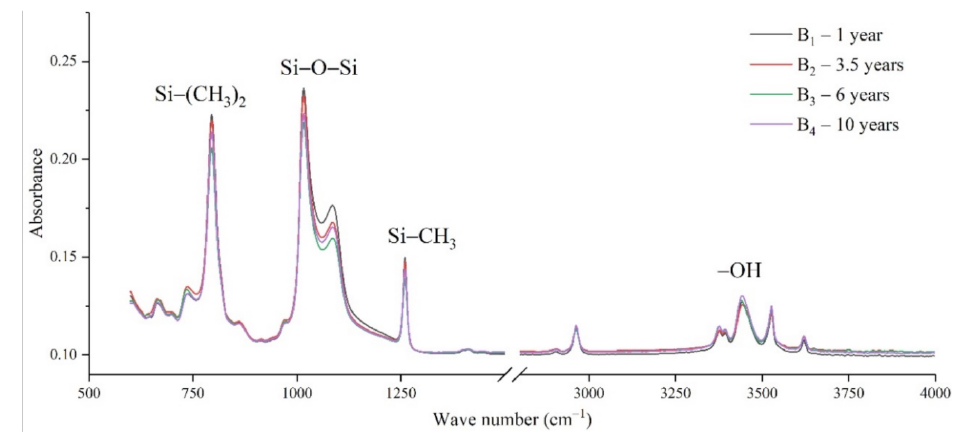
Figure 4. FTIR results of samples from manufacturer B.